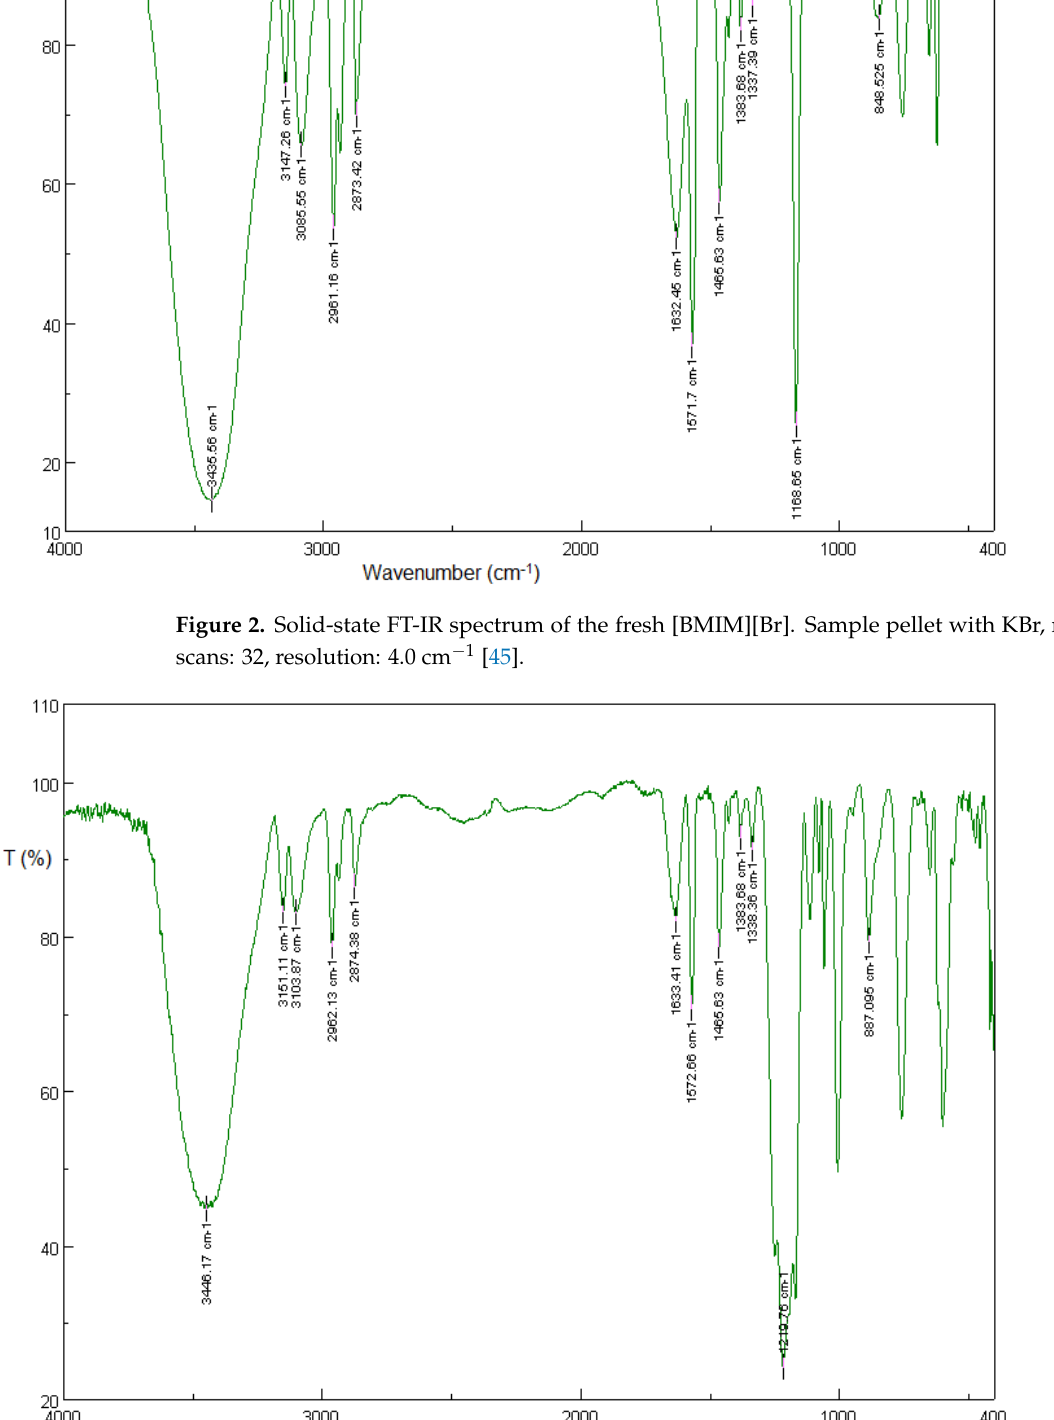
Figure 3. Solid-state FT-IR spectrum of the fresh [BMIM][HSO 4 ]. Sample pellet with KBr, number of − 1 scans: 32, resolution: 4.0 cm − 1 [45]. scans: 32, resolution: 4.0 cm